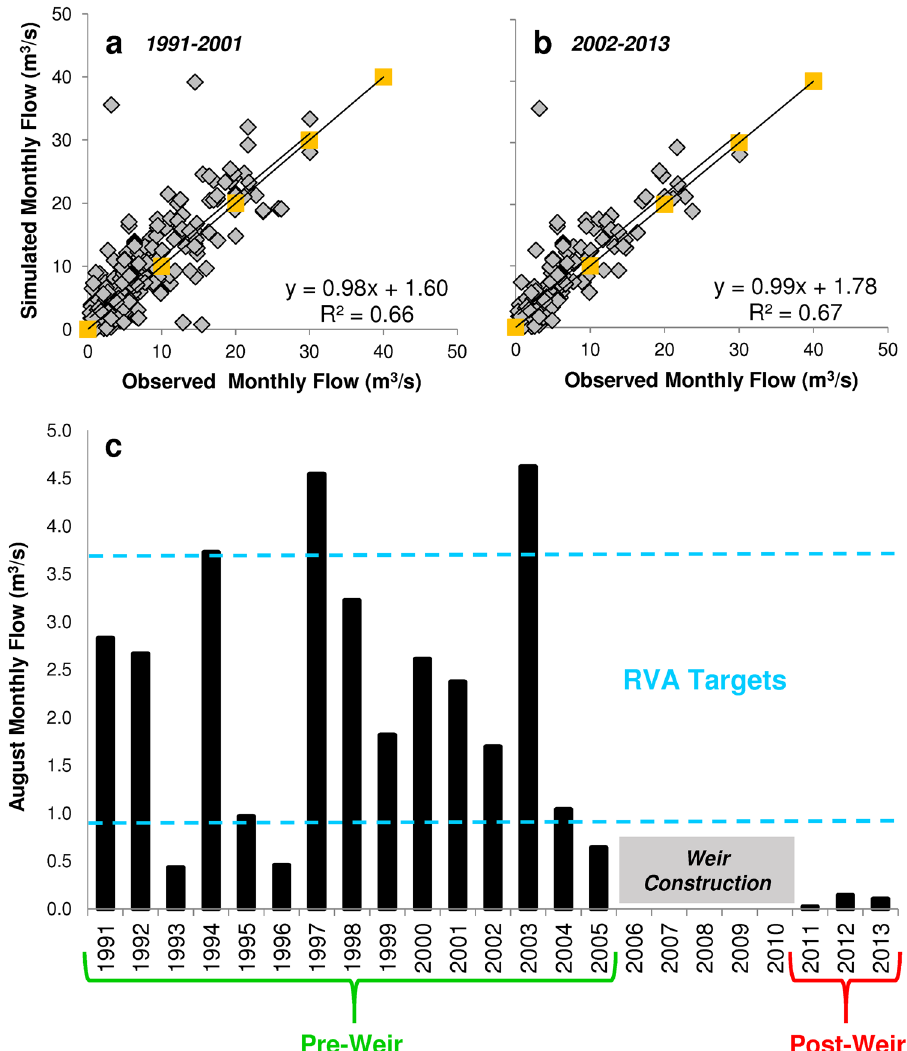
Figure 1. Goodness of fit of simulated (HEC–HMS 3.5 model) and observed (Holombuwa gauging station) flow data, ( a ) model calibration 1991–2001 and ( b ) validation 2002–2013. ( c ) Example of the Range of Variability Approach (RVA) application for the Gurugoda Oya sub-catchment: estimated post-weir values of monthly magnitude of flows in August in comparison to simulated pre-weir